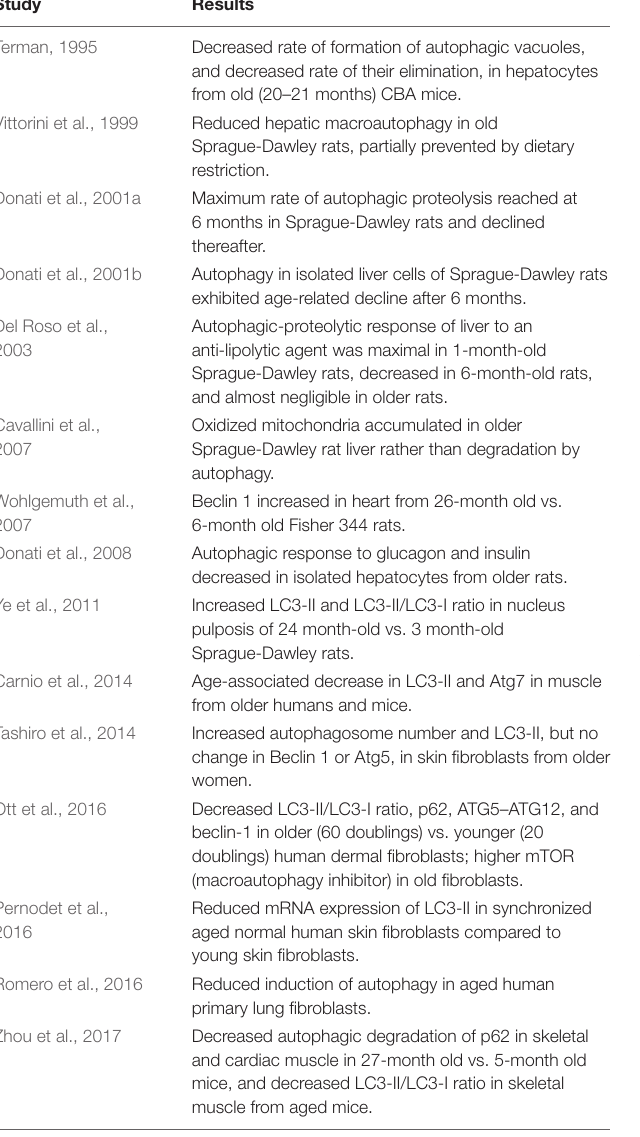
TABLE 4 | Influence of normal aging on macroautophagy in experimental systems other than the CNS. Study Results